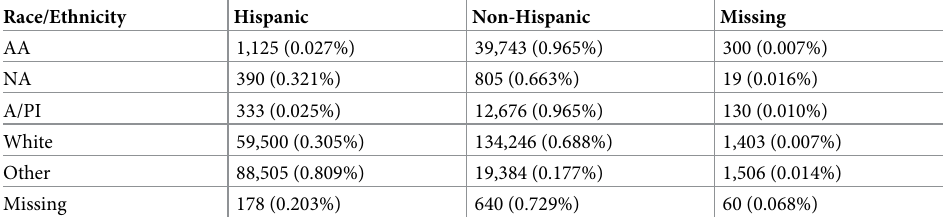
Table 3. Distribution of the Texas PUDF [frequency (percentage)] based on race and ethnicity attributes, where AA: African American, NA:Native America, A/PI: Asian or Pacific Islander. Race/Ethnicity